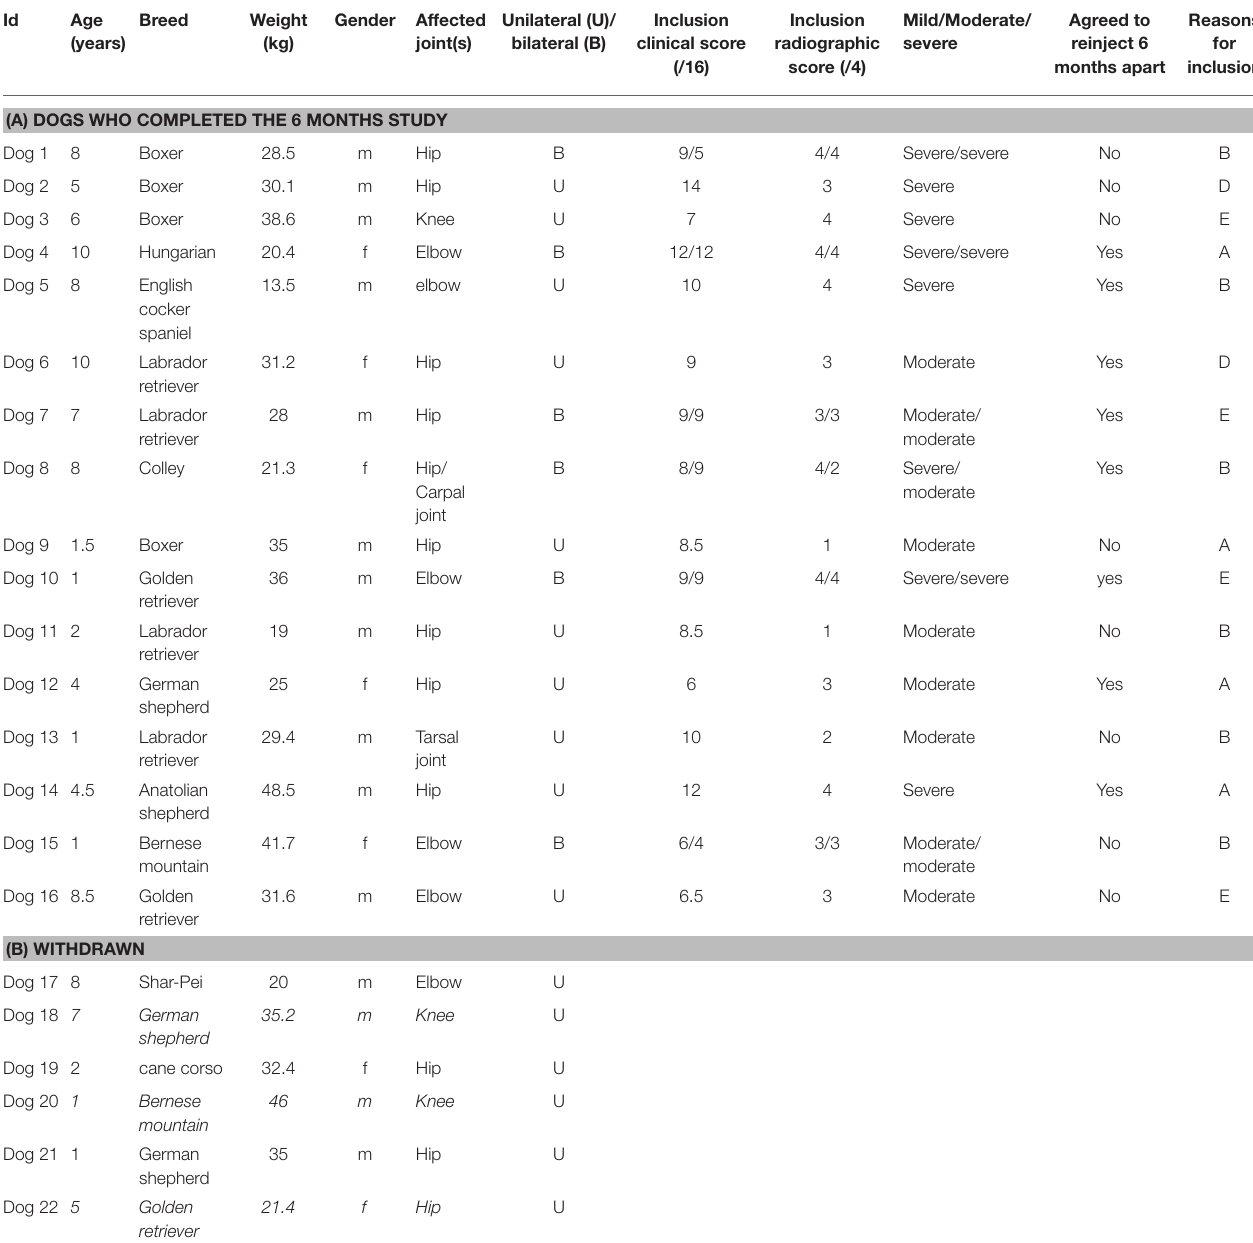
TABLE 2 | Description of the dog